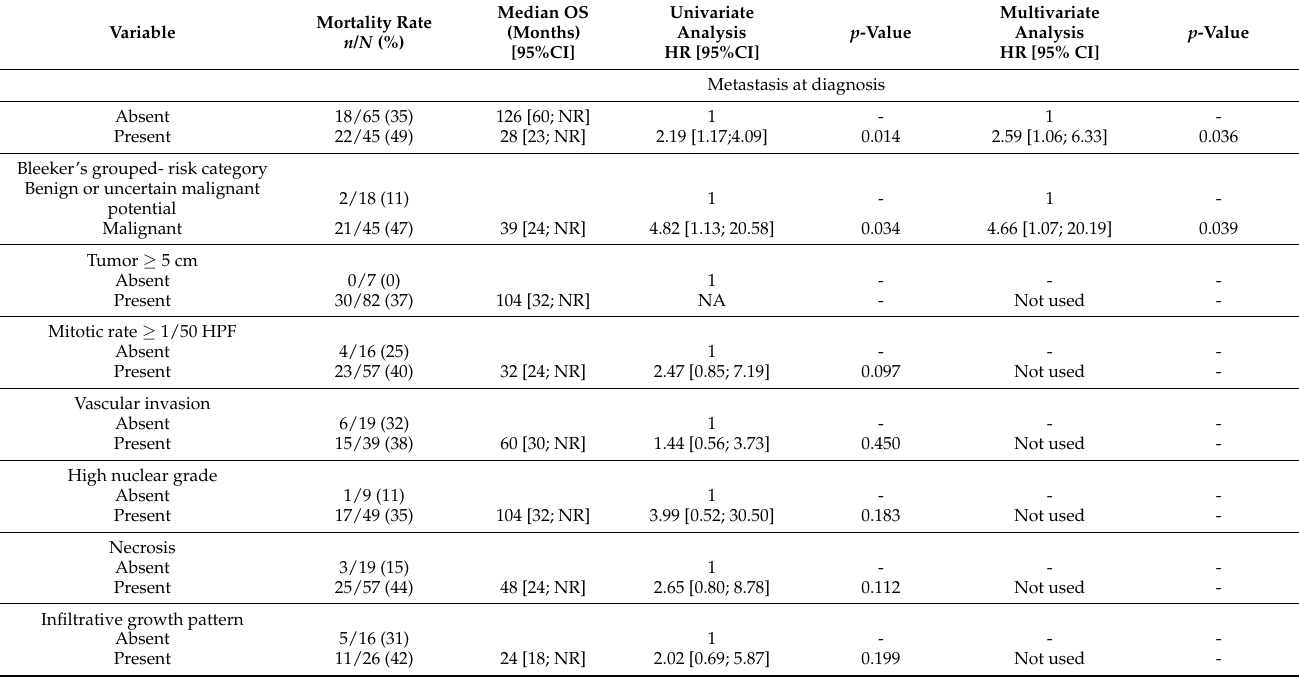
Table 5. Univariate and multivariate analyses of clinical and histologic risk factors related to OS in the whole cohort population ( N = 124). Multivariate analysis on 63